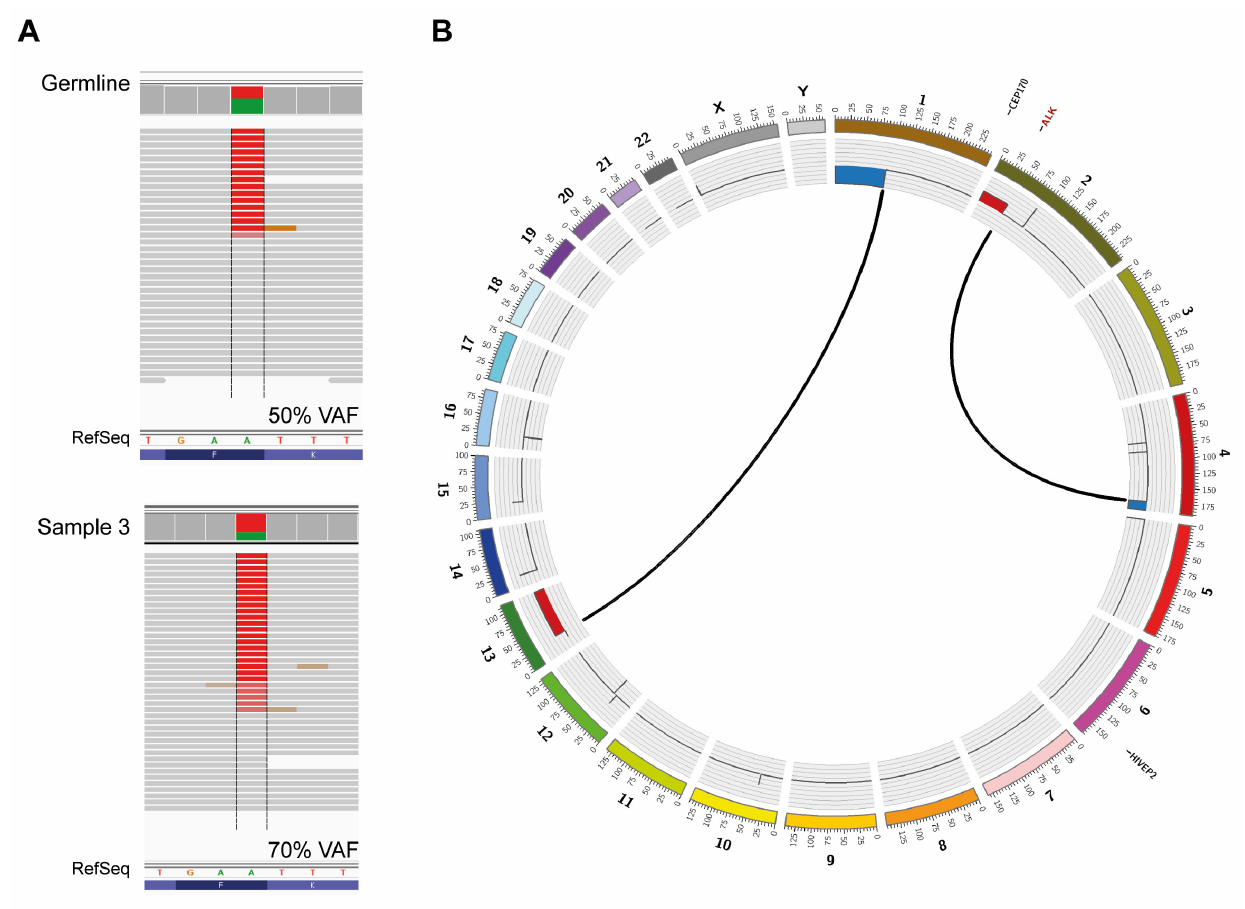
Figure 3. Whole genome sequencing . ( A ) WGS confirms presence of the ALK mutation in consti- tutional and tumor DNA of the patient. Read mapping of sample 3 and constitutional DNA are visualized in IGV. ( B ) Circos plot of sample 3 showing structural variants, copy number alterations, and somatic single nucleotide variants (SNVs). Copy number plots calculated based on the coverage ratio between tumor and corresponding normal tissue are shown on the inner circle, with gain of genomic material indicated in red and loss of genomic material indicated in blue. The lines within the inner circle indicate translocations between chromosomes, while genes affected by somatic SNVs are shown outside the outer circle in black, while the ALK gene, affected by a germline mutation, is shown in red.